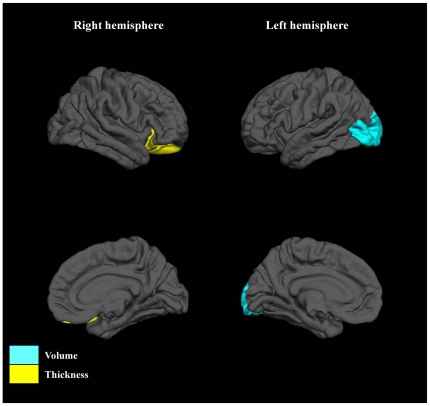
Discriminative pattern for male subjects.Selected regions were differentially colored when volume (blue) or thickness (yellow) of those regions were entered into the model.